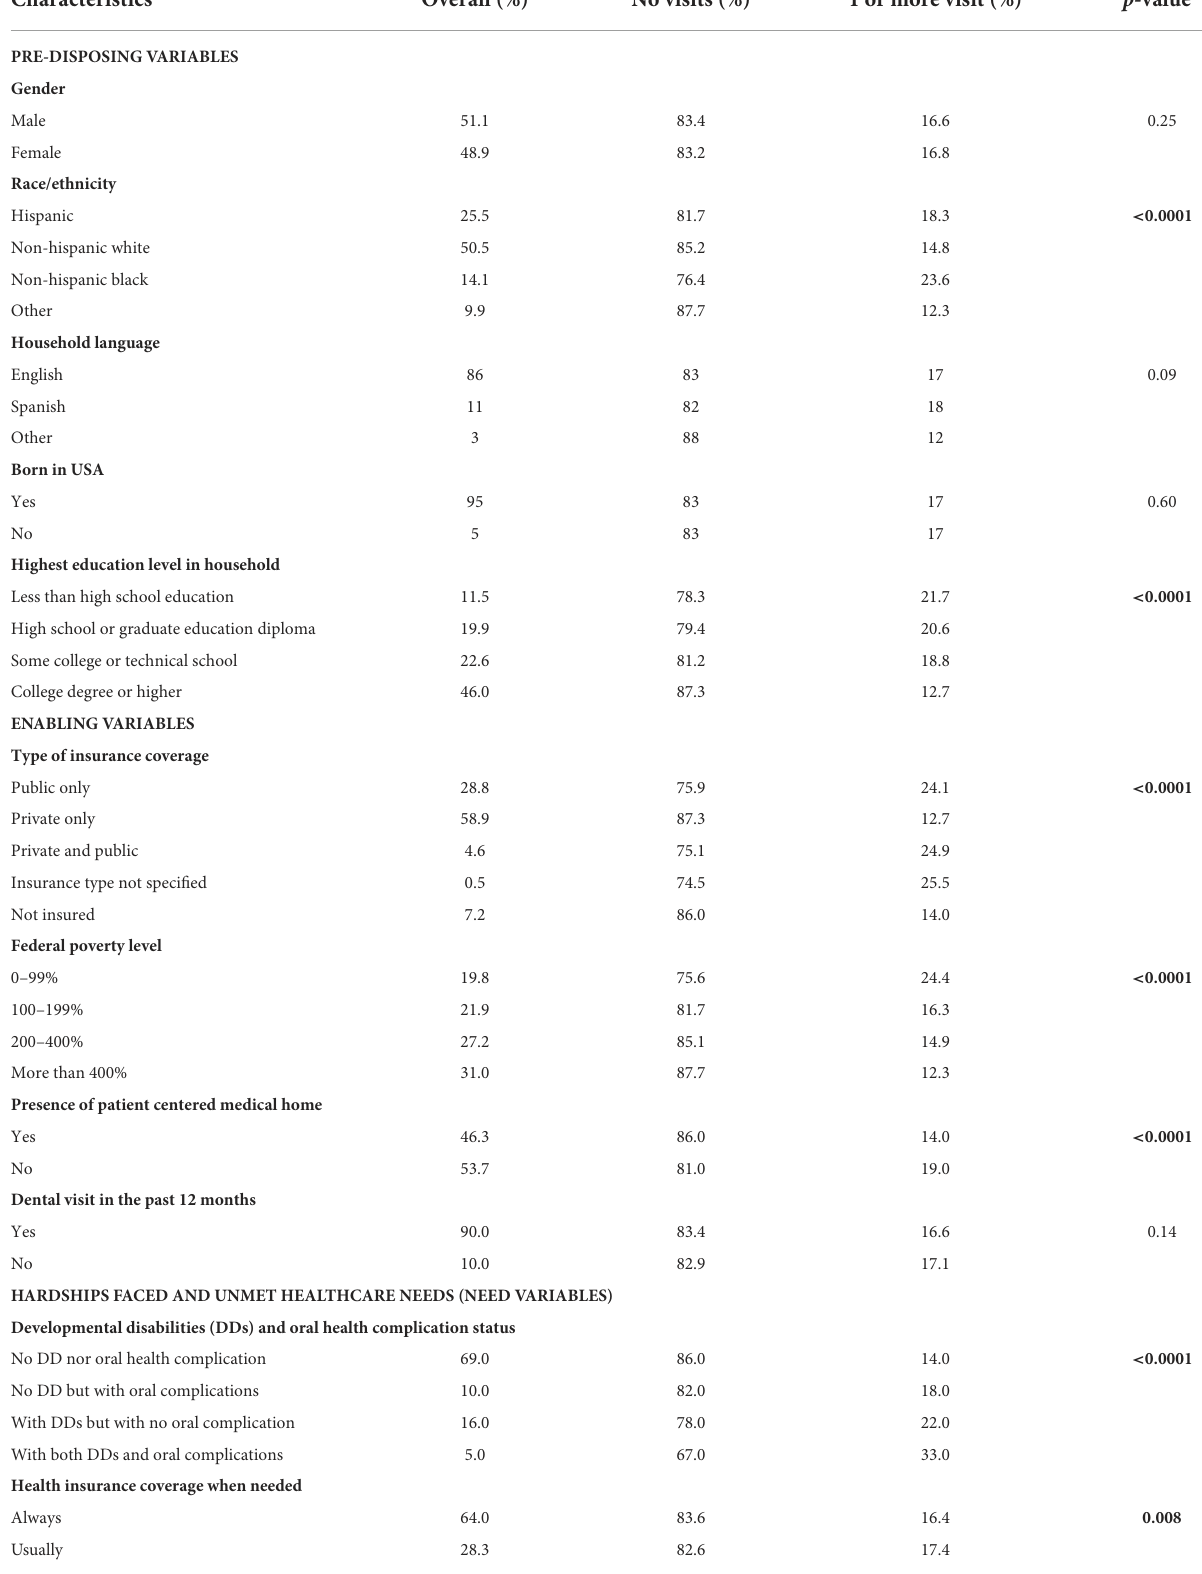
TABLE 1 Emergency room visits by adolescent predisposing, enabling, and healthcare needs. Characteristics Overall